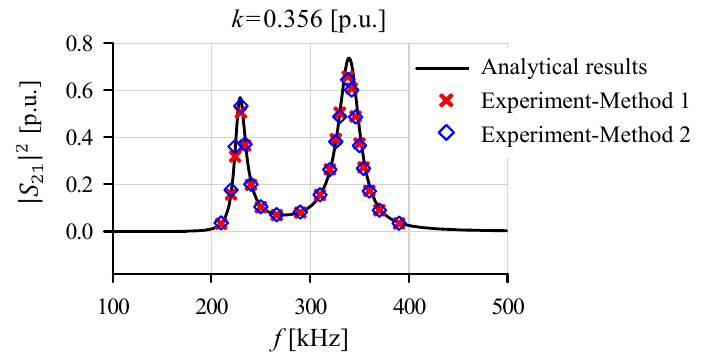
Figure 10. Normalised load power of the asymmetric wireless power transmission system versus operating frequency ( f ).